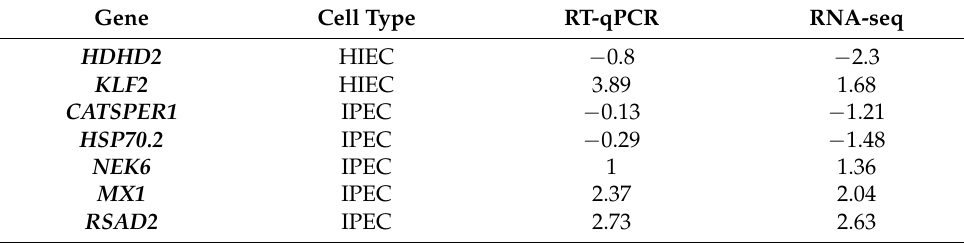
Table 3. Validation of differential expression between RT-qPCR and RNA-seq by selected transcripts *. Gene Cell Type RT-qPCR RNA-seq HDHD2 HIEC − 0.8 − 2.3